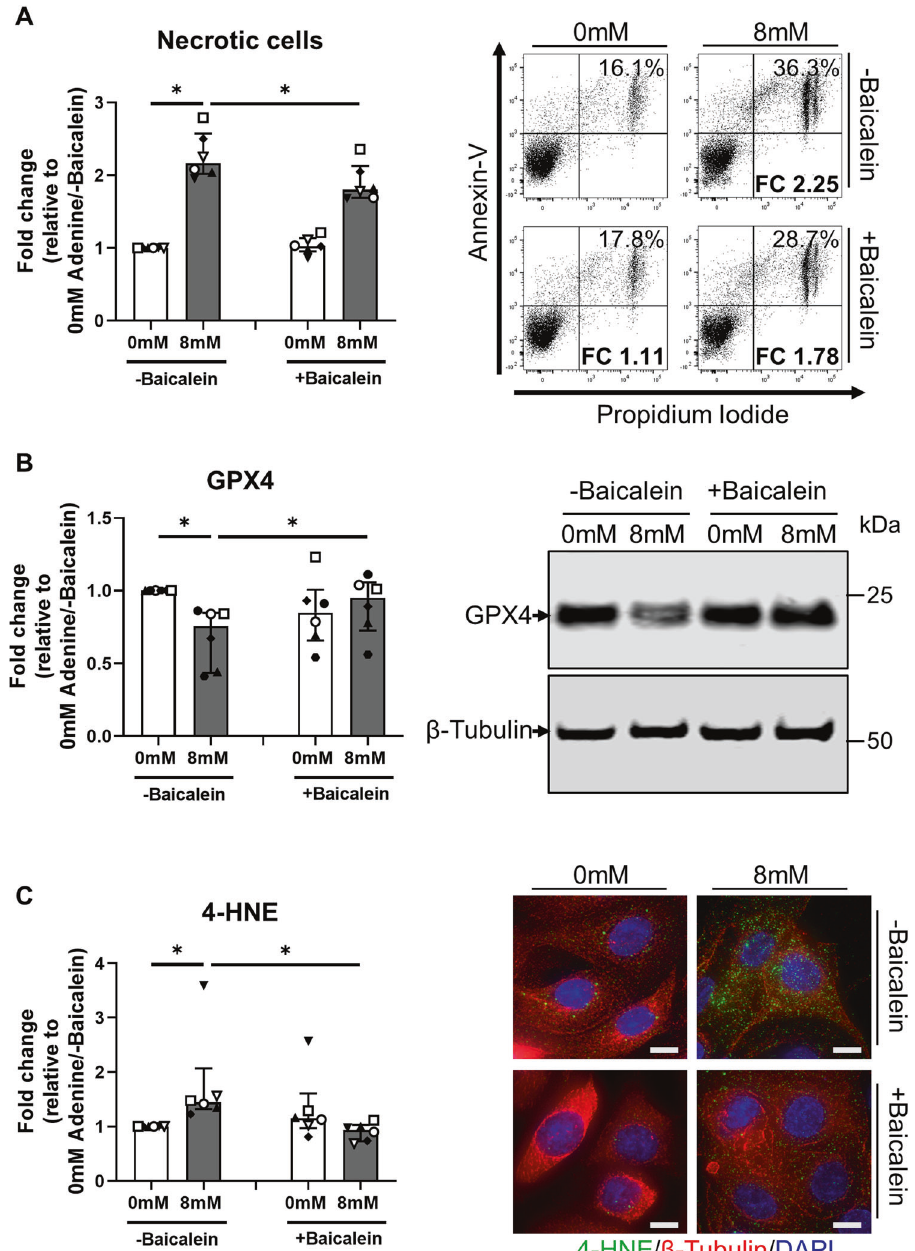
Fig. 4 Baicalein attenuates adenine-induced ferroptotic cell death in human primary PTEC. A Left panel: Fold changes (relative to 0 mM adenine without baicalein treatment) in cellular necrosis (% Annexin-V + PI + cells) for PTEC cultured in the absence (0 mM) and presence (8 mM) of adenine, both without (-baicalein) and with ( + baicalein) treatment. Bar graphs represent median values with interquartile range. Symbols represent individual donor PTEC; n = 6. * p < 0.05, Wilcoxon matched-pairs signed-rank test. Right panel: Representative donor Annexin-V/PI dot plots of PTEC cultured in the absence (0 mM) and presence (8 mM) of adenine, both without (-baicalein) and with ( + baicalein) treatment. The percentage of Annexin-V + PI + necrotic cells for each dot plot are presented, with fold change (FC) values relative to 0 mM adenine without baicalein treatment also shown. B Left panel : Fold changes (relative to 0 mM adenine without baicalein treatment) in GPX4 expression for PTEC cultured in the absence (0 mM) and presence (8 mM) of adenine, both without (-baicalein) and with ( + baicalein) treatment. Bar graphs represent median values with interquartile range. Symbols represent individual donor PTEC; n = 6. * p < 0.05, Wilcoxon matched-pairs signed-rank test. Right panel: Representative GPX4 Western blot for PTEC cultured in the absence (0 mM) and presence (8 mM) of adenine, both without (-baicalein) and with ( + baicalein) treatment (15 µg total protein per lane). C Left panel: Fold changes (relative to 0 mM adenine without baicalein treatment) in 4-HNE expression (measured as mean CTCF of >50 cells per condition) for PTEC cultured in the absence (0 mM) and presence (8 mM) of adenine, both without (-baicalein) and with ( + baicalein) treatment. Bar graphs represent median values with interquartile range. Symbols represent individual donor PTEC; n = 6. * p < 0.05, Wilcoxon matched-pairs signed-rank test. Right panel: Immuno fl uorescent microscopy of representative PTEC cultured in the absence (0 mM) and presence (8 mM) of adenine, both without (-baicalein) and with ( + baicalein) treatment, and stained for 4-HNE (green), β -tubulin (red) and DAPI (blue). Scale bars represent 20 μ m.